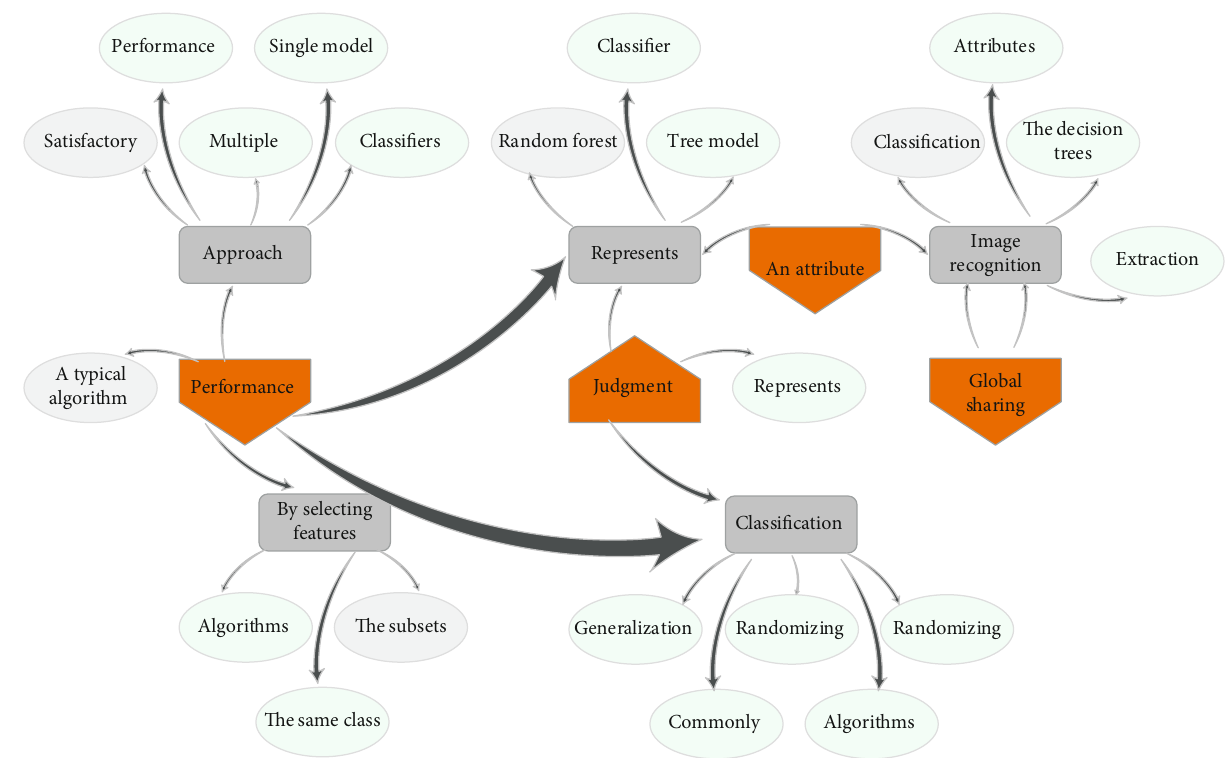
Figure 1: CNN network structure